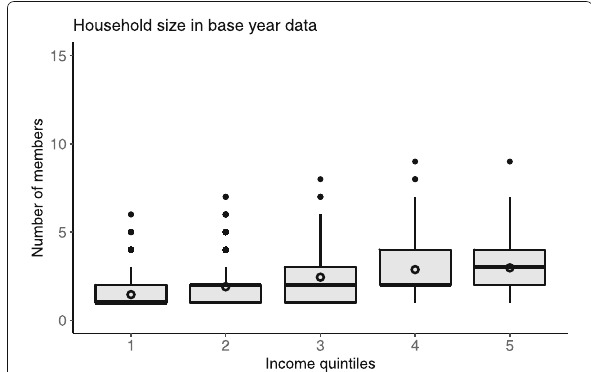
Fig. 7 Distribution of household size within and across income quintiles. Note: Income quintiles are according to allocation by the statistical office. The circles show mean values